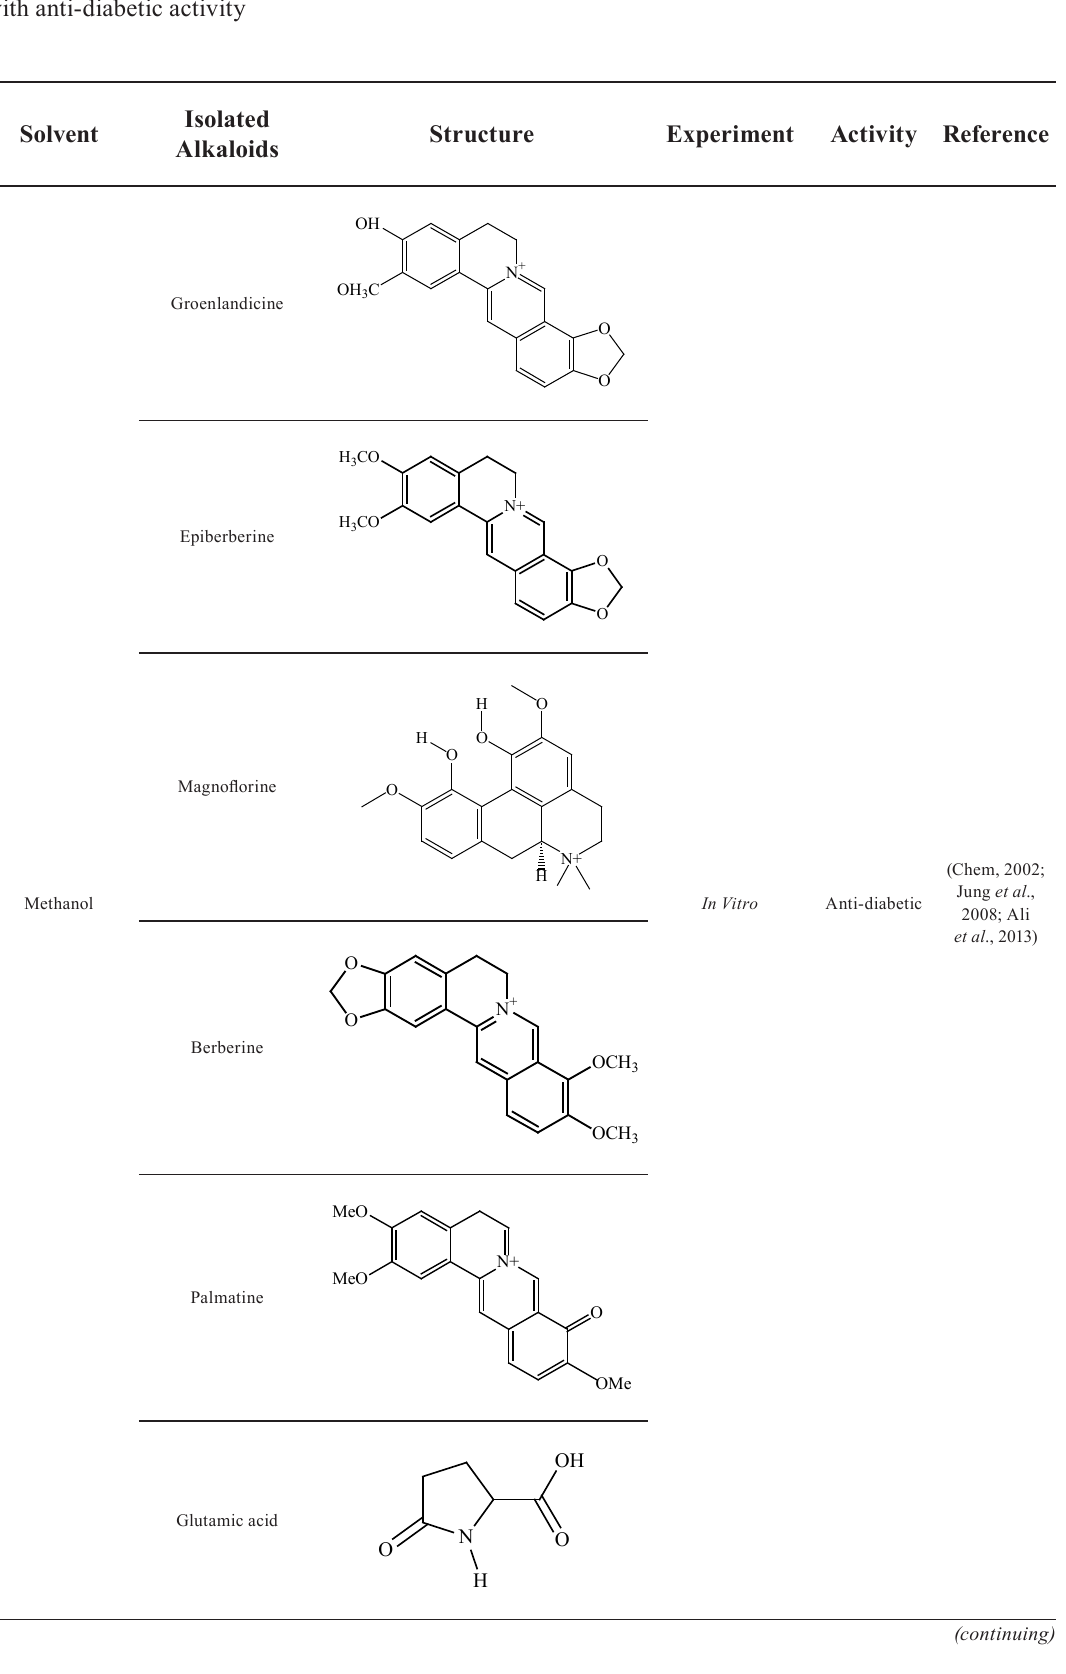
TABLE I – A lkaloids with anti-diabetic activity